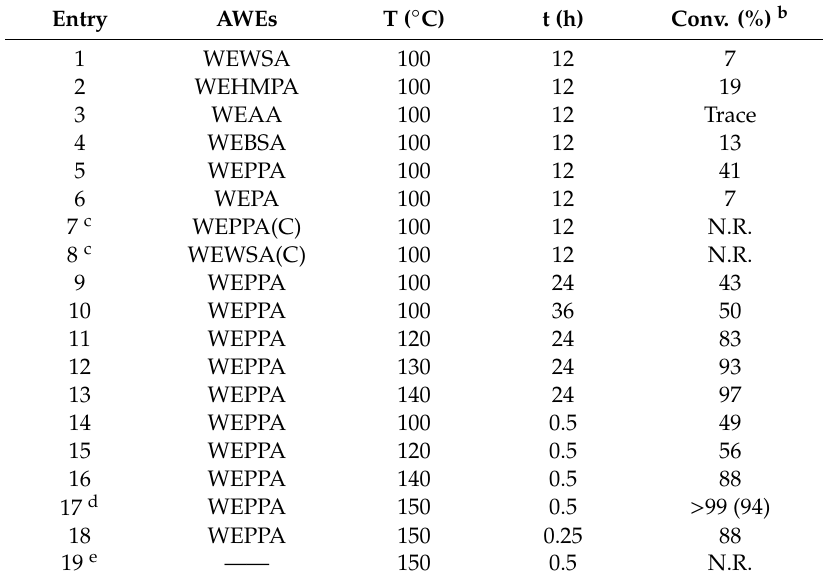
Table 3. Optimization of reaction conditions for the hydration of benzonitrile 1a in AWEs a